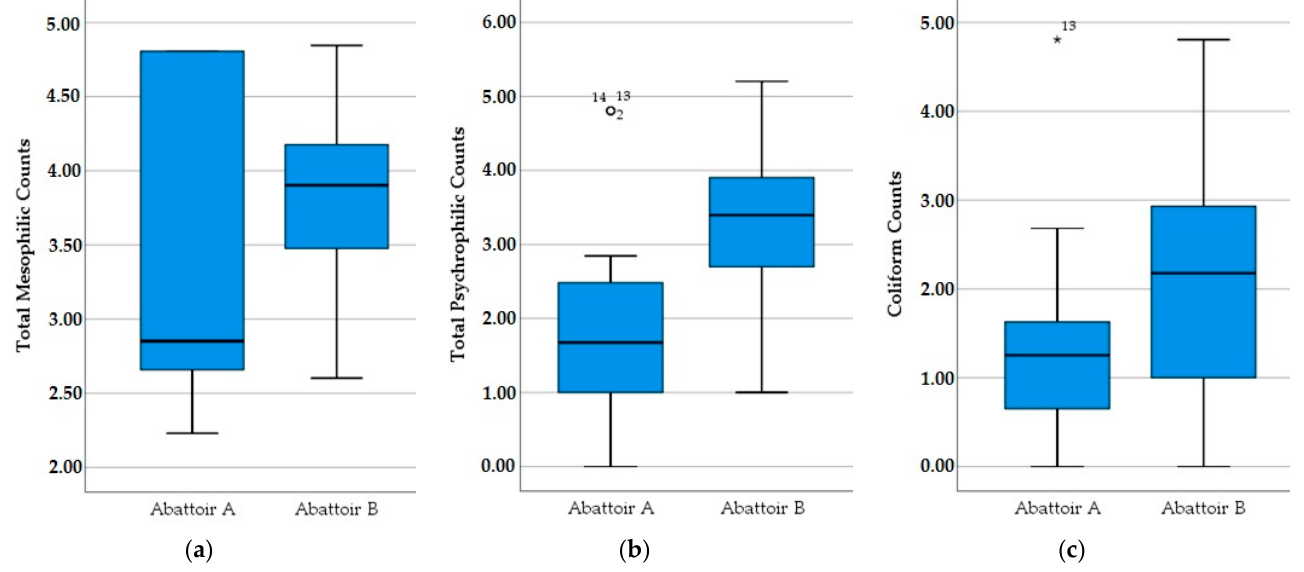
Figure 2. Total mesophilic, total psychrophilic and coliform counts (in log 10 CFU/cm 2 ) of sheep and goat carcasses in the two abattoirs. * The star value is generally accepted as values exceeding the quartetiles. ( a ) Total Mesophilic Counts, ( b ) Total Psychrophilic Counts, ( c ) Coliform Counts.